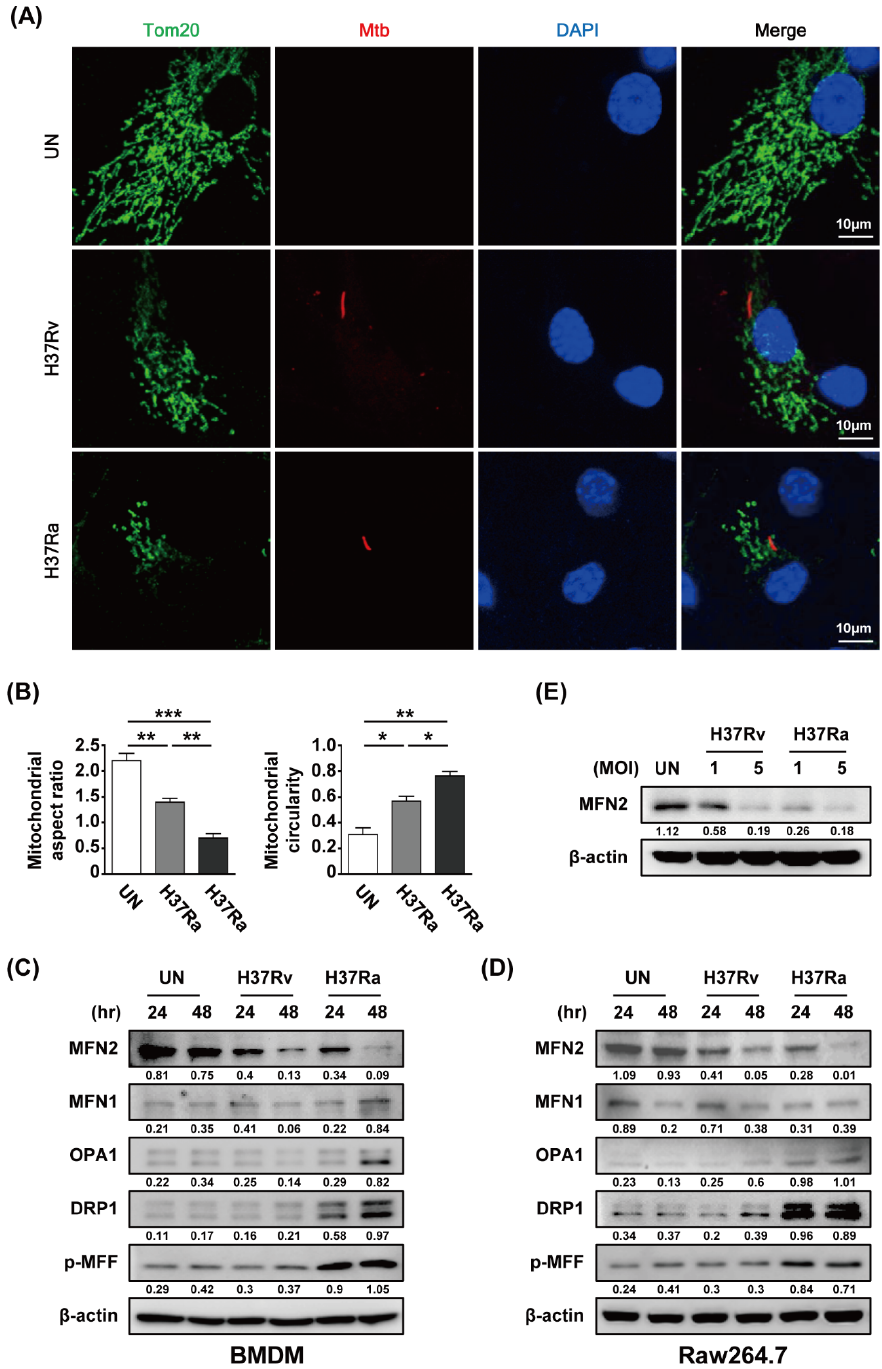
Figure 2. Mtb induces mitochondrial fragmentation in macrophages. ( A ) BMDMs were infected with RFP-labeled Rv or Ra (red), incubated for 48 h, stained with Tom20 to detect mitochondria (green) and DAPI to visualize nuclei (blue), and visualized using confocal microscopy. ( B ) Quantification of the mitochondrial morphology (aspect ratio; left, and circularity; right) in ( A ). ( C , D ) Cells were harvested and subjected to western blotting for mitochondrial fusion / fission factors (such as MFN1 / 2, OPA1, Drp1, and p-MFF); β -actin was used as the loading control. ( E ) BMDMs were infected with Rv or Ra (MOI = 1 to 5) for 3 h, and then incubated 48 h. Western blotting analysis was performed using antibodies directed against MFN2 and β -actin. Data are representative of three independent experiments. Statistically significant di ff erences are indicated; * p < 0.05, ** p < 0.01, and *** p <